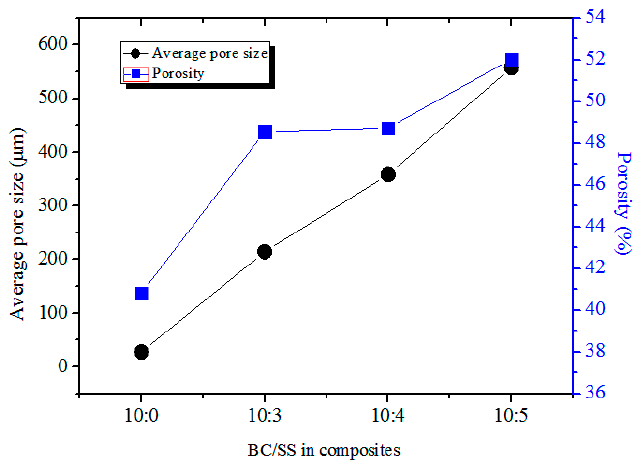
Figure 7. Average pore size and porosity of the composites with different BC/SS.